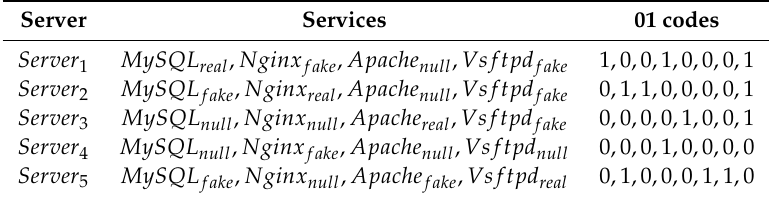
Figure 2. Distribution of all services at t 0 . Table 3. The overall information of services at t 0